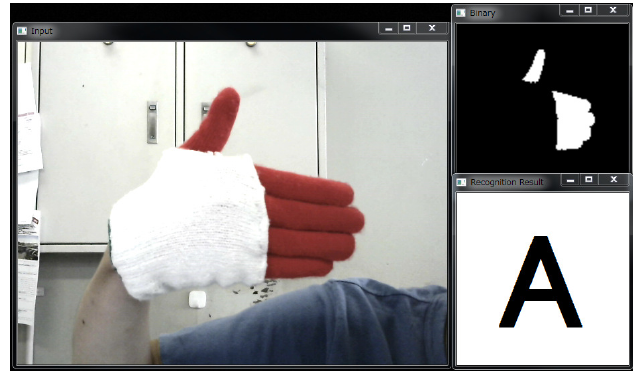
Figure 5. Real-time gesture recognition system.